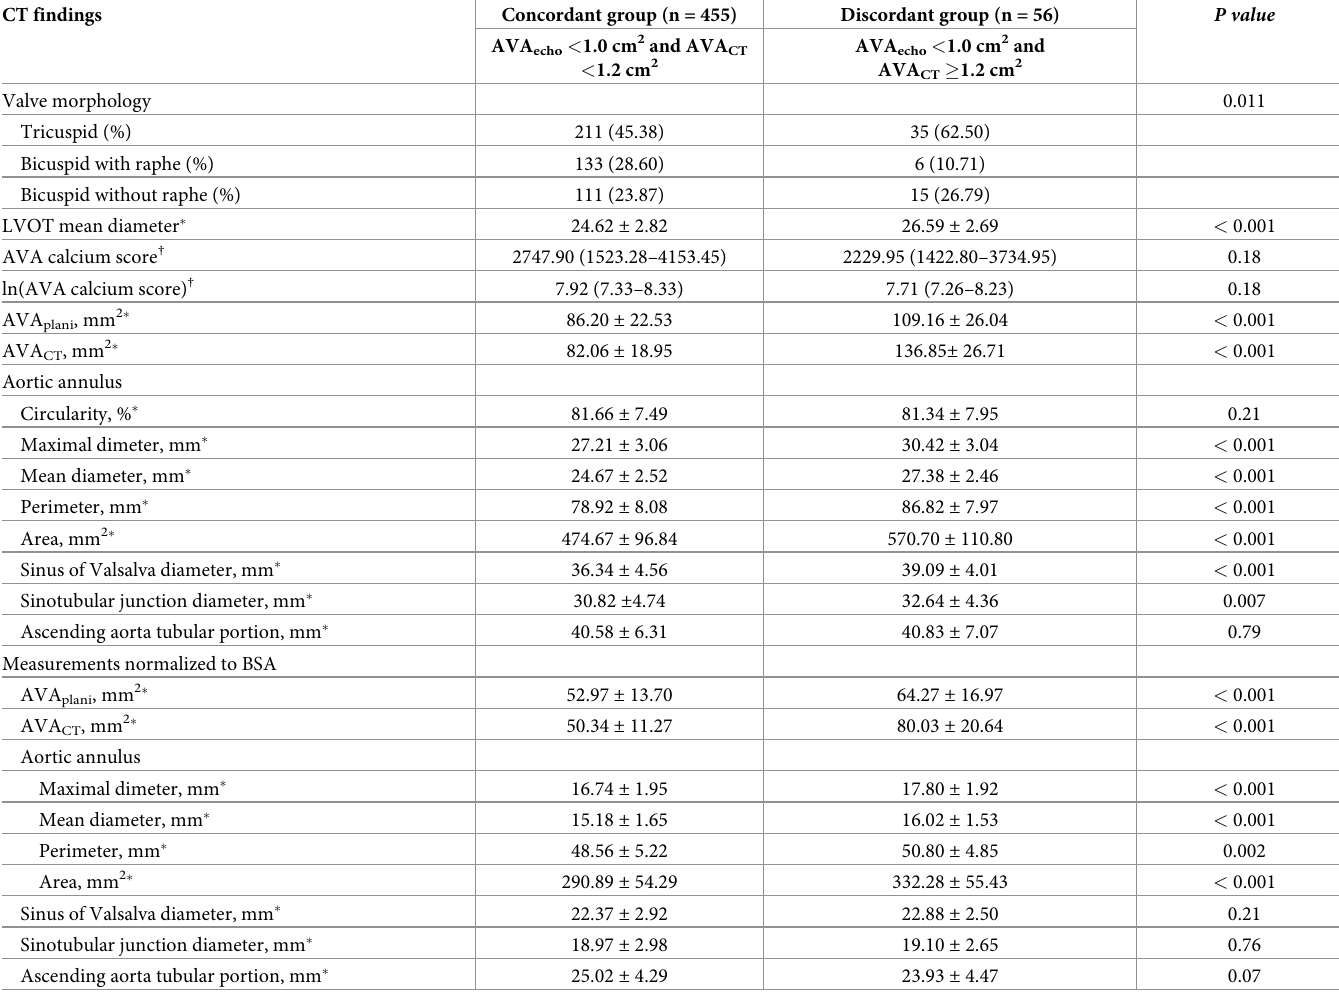
Table 3. CT findings of concordant and discordant groups between AVA values measured by echocardiography and CT in severe